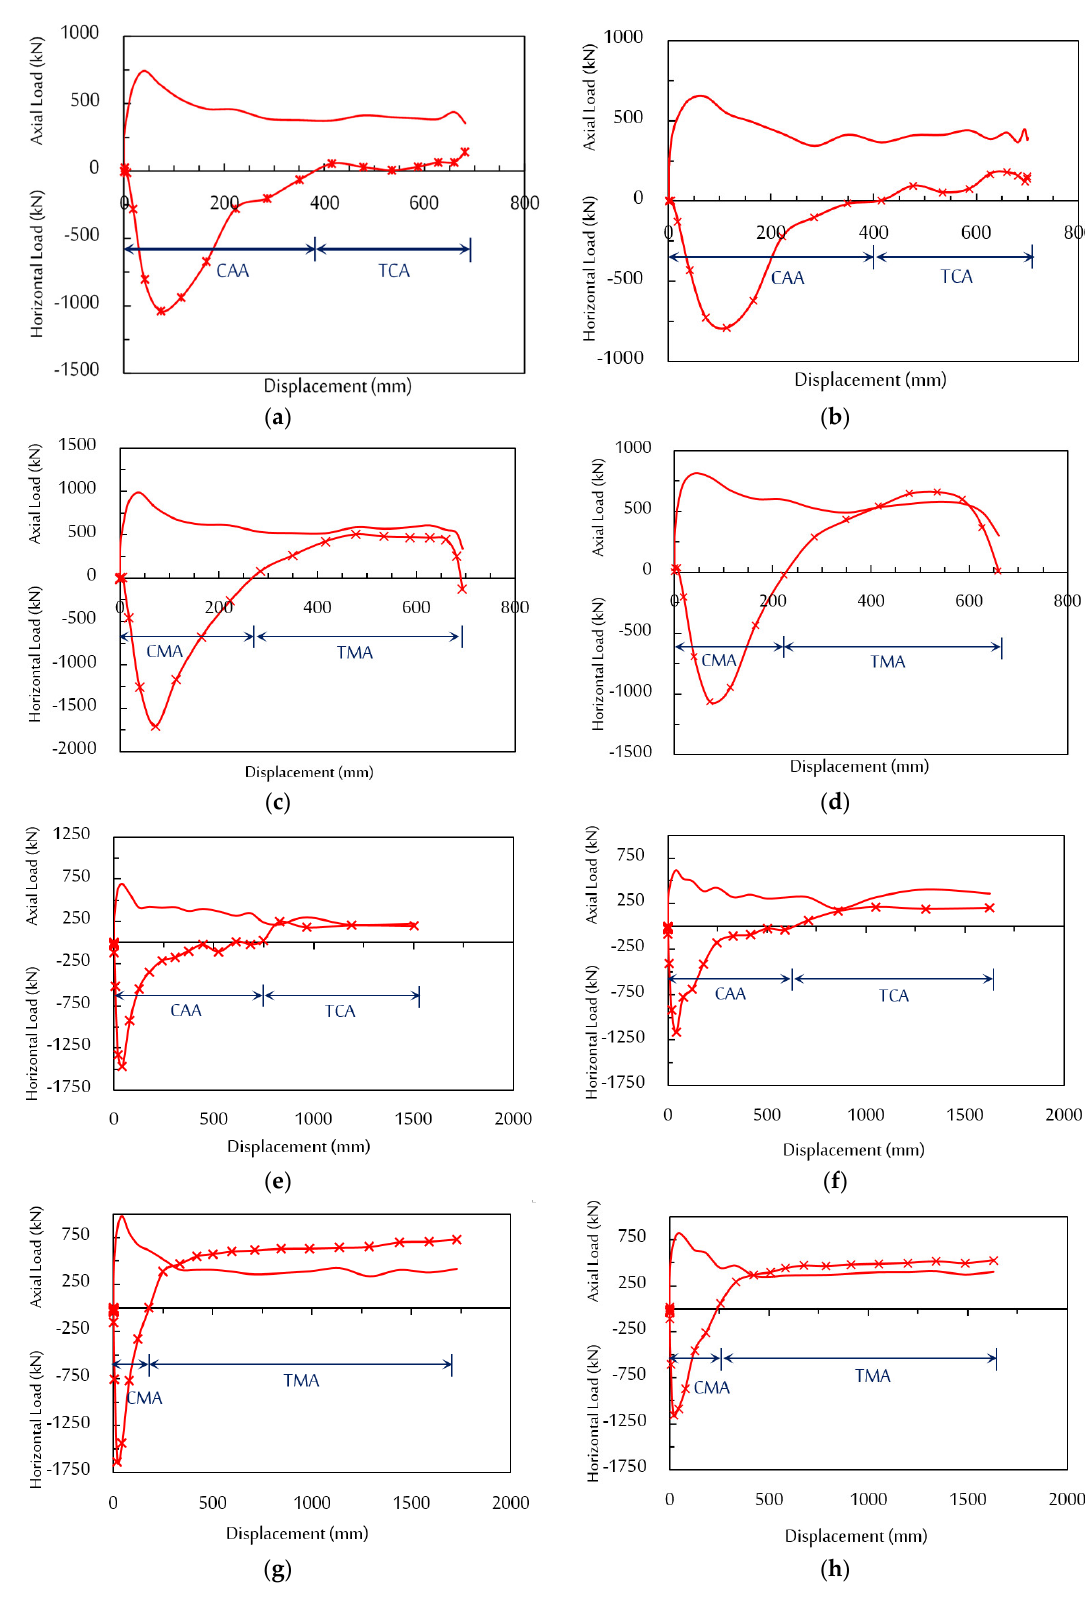
Figure 22. Load resistance mechanisms: ( a ) NC-MID; ( b ) RuC-MID; ( c ) NC-MID-Slab; ( d ) RuC-MID- Slab; ( e ) NC-COR; ( f ) RuC-COR; ( g ) NC-COR-Slab; and ( h ) RuC-COR-Slab.